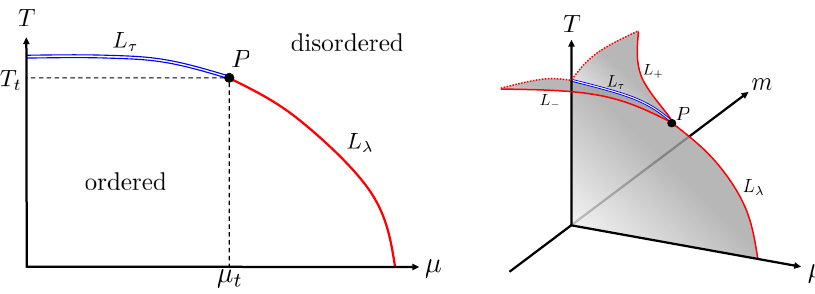
Figure 1 . Schematic phase diagram of a system in which a TCP emerges. We use temperature T , chemical potential µ , and quark mass m as parameters. The left panel shows the phase diagram of the m = 0 plane. The blue double and red solid line denote the first and second order phase transition points, called the triple line ( L τ ) and λ -line ( L λ ), respectively. The point P denotes the TCP. In the three dimensional phase diagram (right panel), two extra red lines denote the second order phase transition points, corresponding to the lines of the critical end points ( L ± ). The gray shaded surfaces denote the first-order phase transition